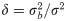
Pointwise power under different block variances.The arrow size and direction represent the approximate effect size and direction of a QTL, respectively. (A) δ = 0.5; (B) δ = 1; (C) δ = 5; (D) δ = 10. δ represents the size of the block variance and is defined as δ=σb2/σ2, where σ
2 is the error variance and σb2 is the variance of a block within the replication. Pointwise power was calculated as the proportion of replications whose LOD score at each testing position was greater than the threshold determined by a permutation test with 1000 replications.